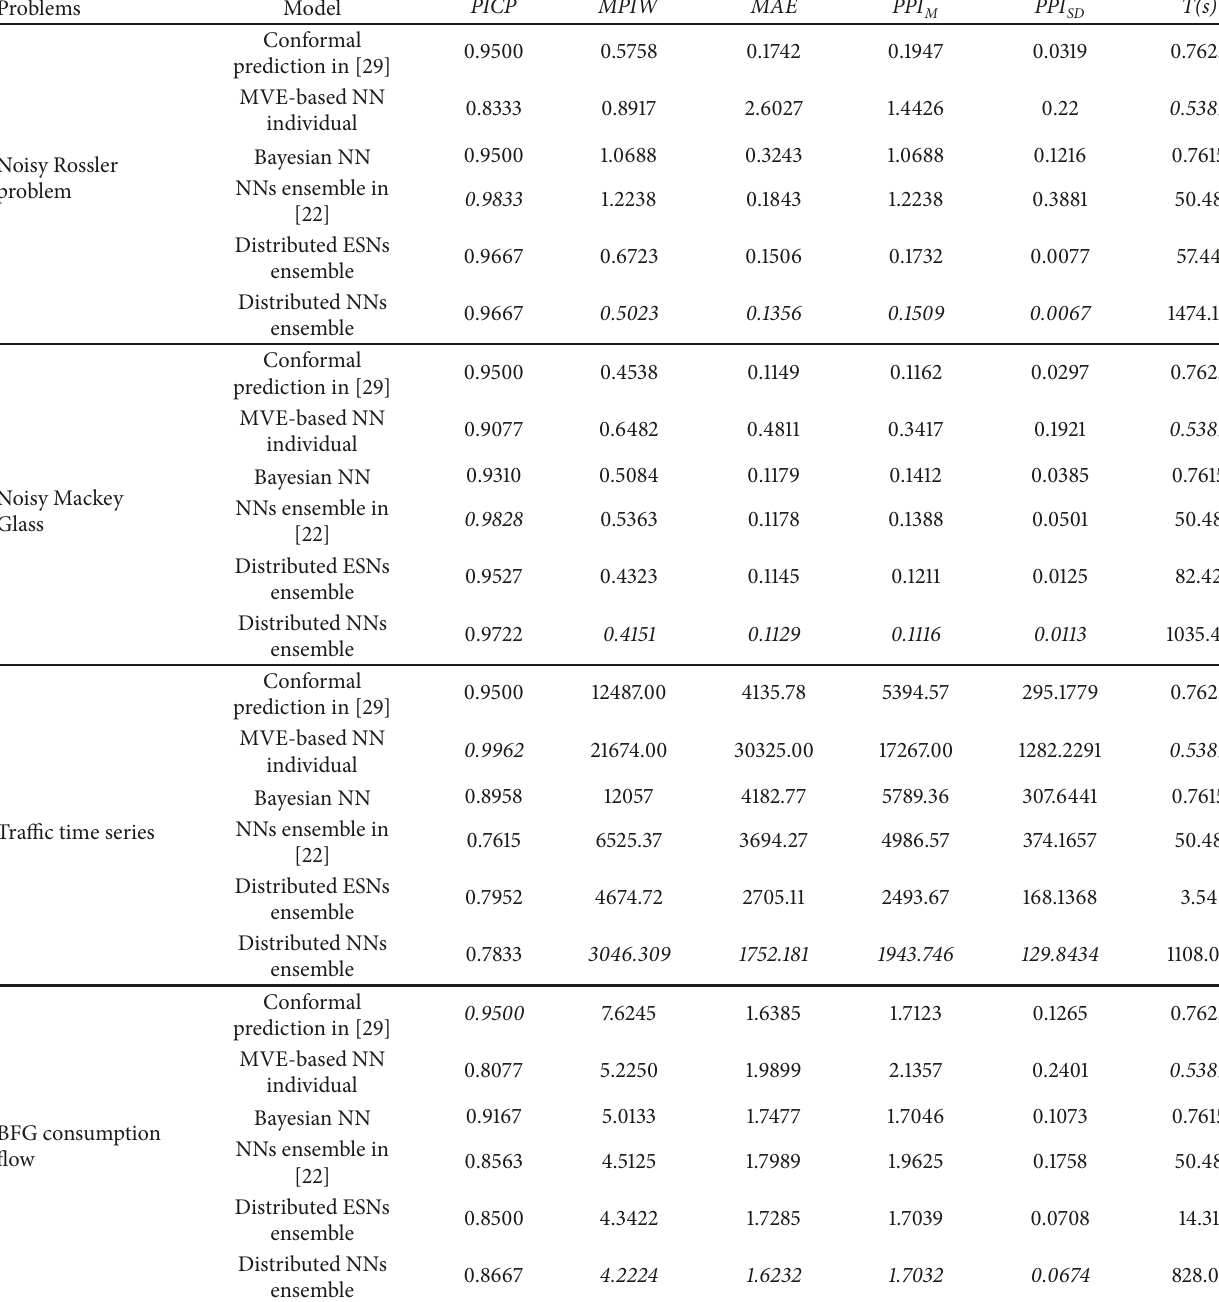
Table 5: Statistical analysis of the comparative experiments.